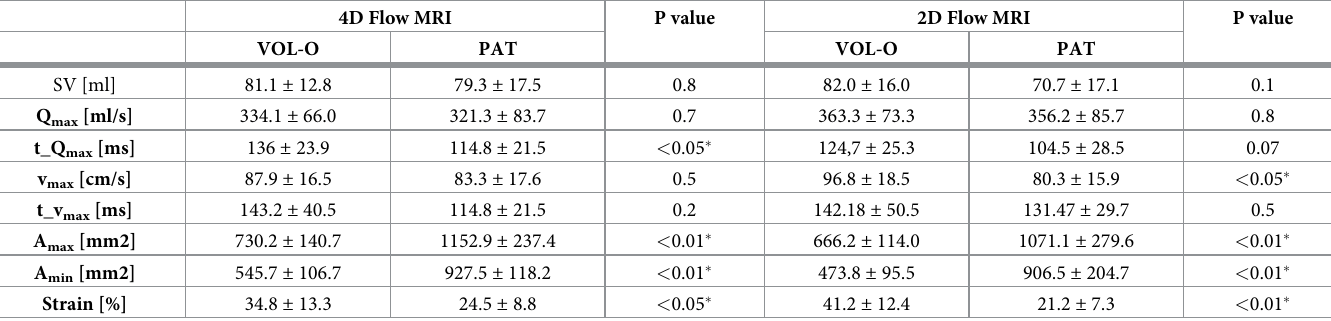
Table 2. Comparison of hemodynamic and anatomical parameters between aged-matched, healthy volunteers (VOL-O) and patients with PH (PAT).